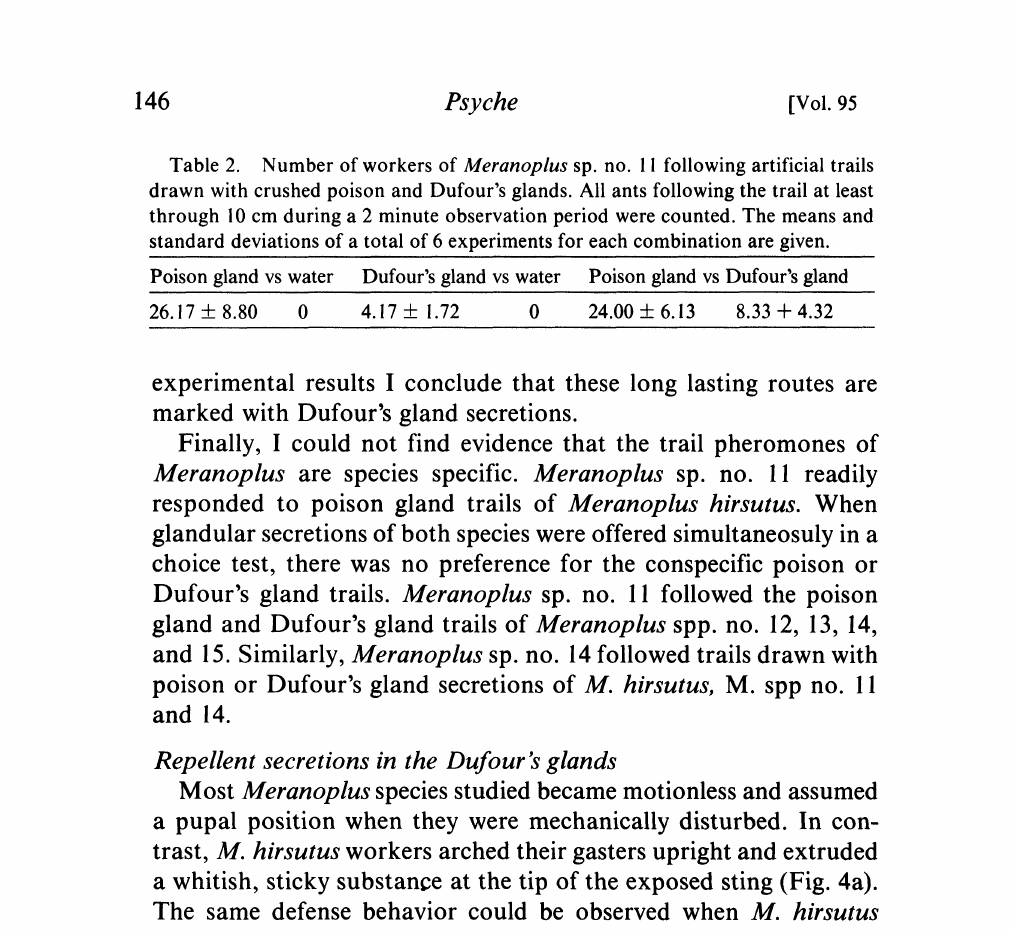
Table 2. Number of workers of Meranoplus sp. no. 11 following artificial trails drawn with crushed poison and Dufour’s glands. All ants following the trail at least through 10 cm during a 2 minute observation period were counted. The means and standard deviations of a total of 6 experiments for each combination are